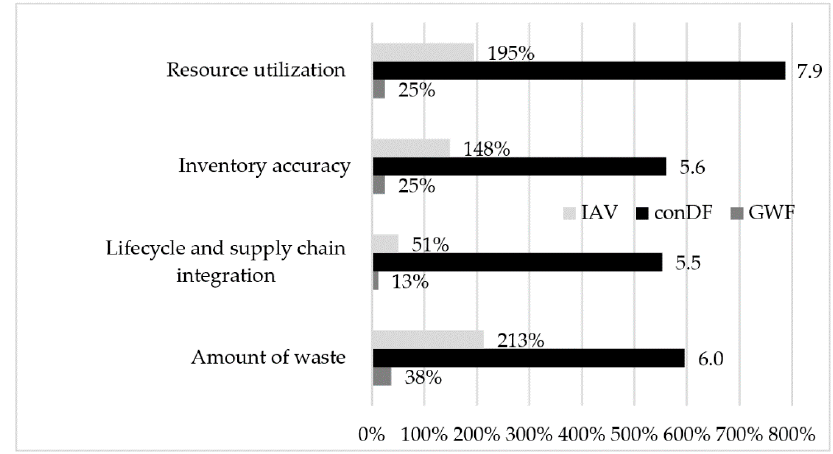
Figure 6. Assessment system results.